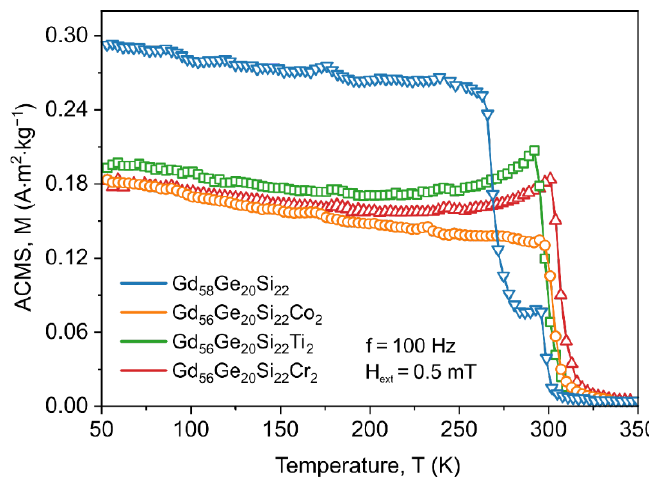
Figure 4. Temperature dependence of AC magnetic susceptibility (ACMS) for the annealed Gd 58 Ge 20 Si 22 , Gd 56 Ge 20 Si 22 Co 2 , Gd 56 Ge 20 Si 22 Ti 2 and Gd 56 Ge 20 Si 22 Cr 2 alloys measured at zero external magnetic field for the excitation AC magnetic field of 0.5 mT and frequency of 100